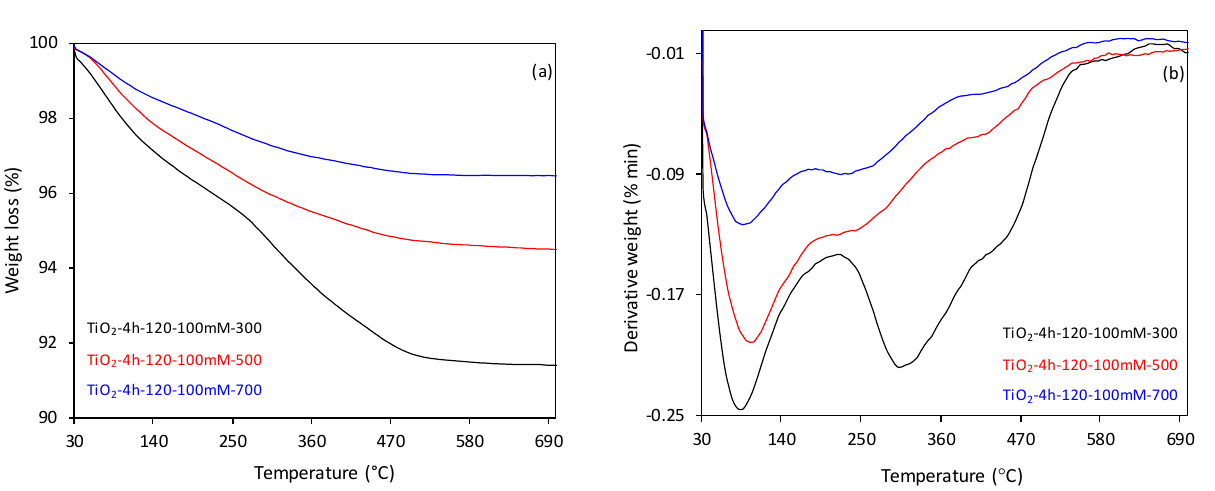
Figure 4. ( a ) TG and ( b ) DTG curves of the APTES modified nanomaterials. Additionally, the strong decomposition peaks between the 200–390 ◦ C for the TiO 2 -4 h- 120-100 m-300 samples, corresponding to the differential thermogravimetric (DTG)